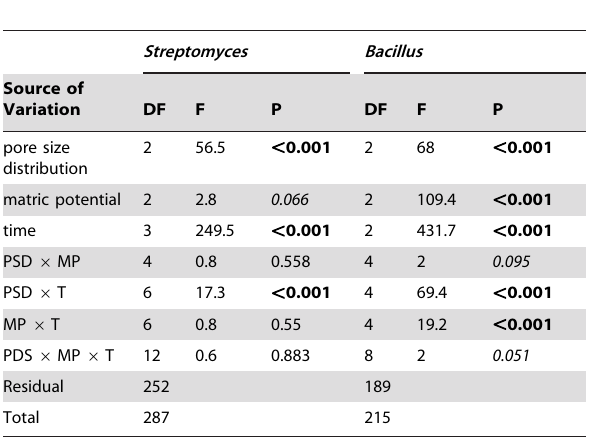
Table 1. Three-way ANOVA of factors affection expansion of bacteria in sand